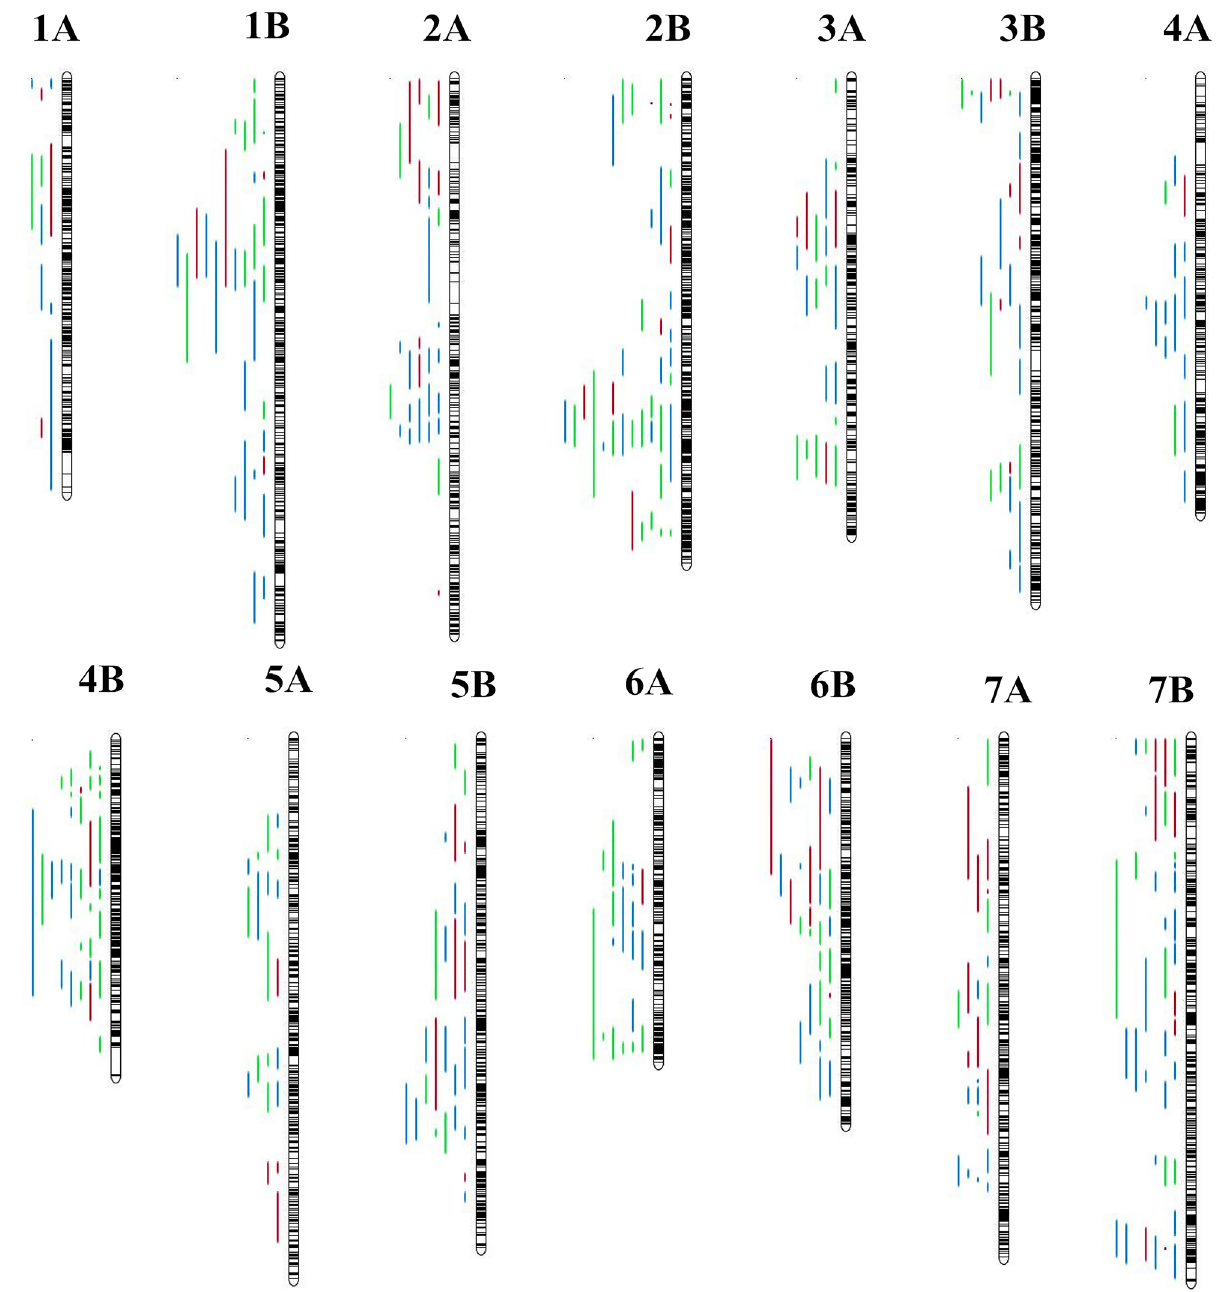
Figure 1. QTL distribution along durum wheat genome chromosomes A and B. Colour code: green: abiotic stress QTL; orange: biotic stress QTL; blue: quality QTL. Black bars within chromosomes represent marker